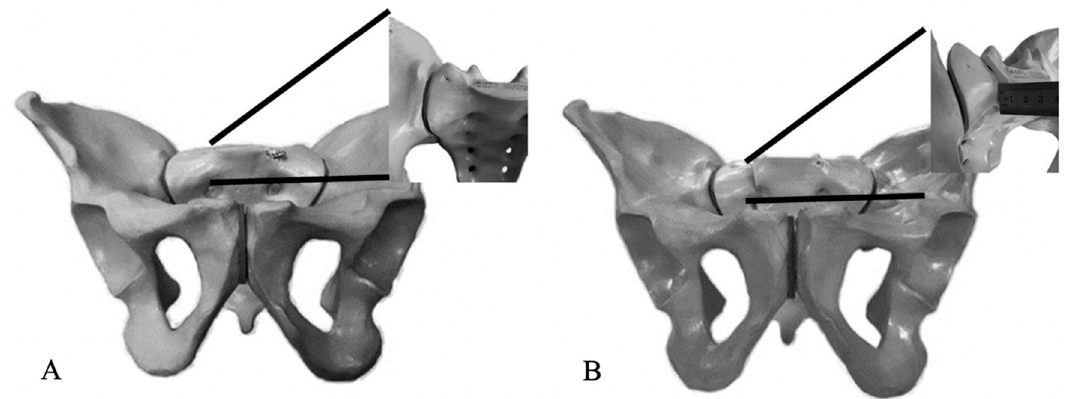
Figure 1. The projection of the pelvic ring on an outlet view can fail to identify a 1 cm vertical displacement as proven by the inset images. ( A ) Anatomically reduced injury, and ( B ) injury mal- reduced by 1 cm.